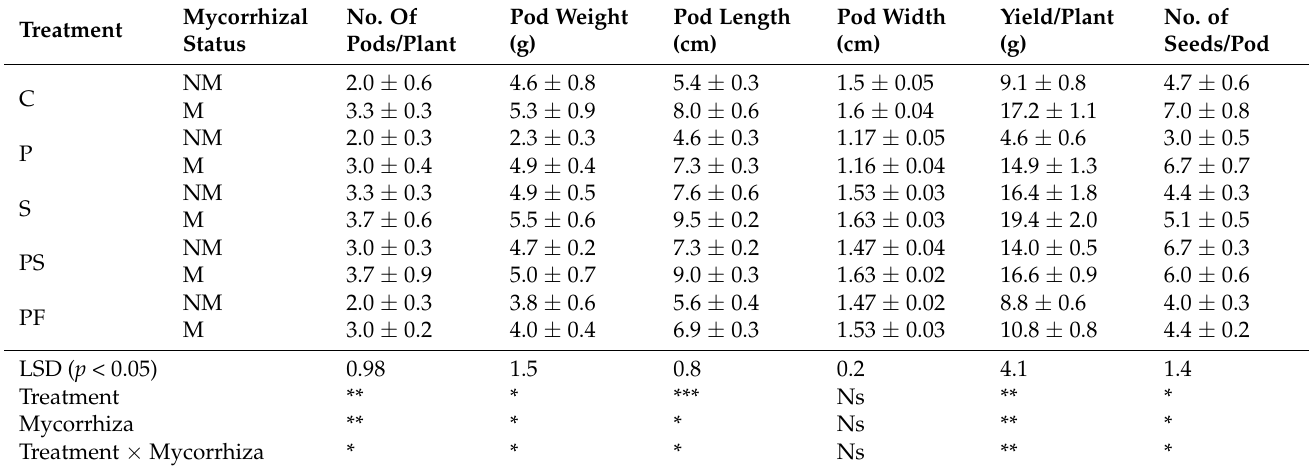
Table 4. Effects of application of S. viridosporus HH1 and/or colonization with R. irregularis on yield